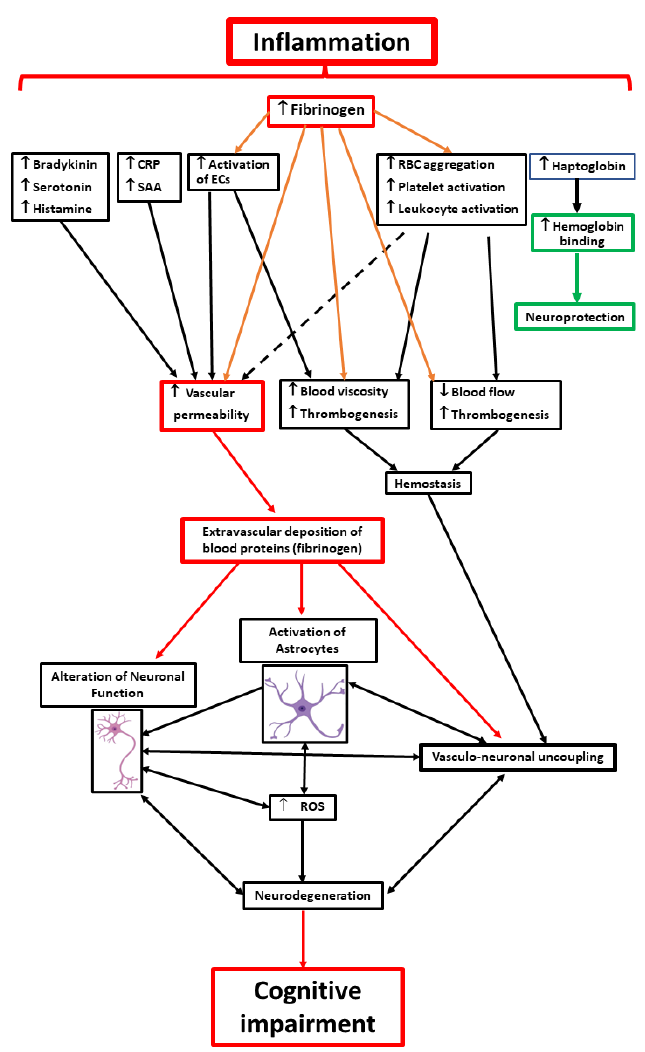
Figure 1. Schematic representation of the hypothesis of inflammation-induced vascular cognitive impairment. Among other factors that can affect vasculo-neuronal uncoupling, the factor that stands out is fibrinogen (Fg). It can be involved in changes of vascular permeability in various ways. Changes in vascular permeability result in direct activation of astrocytes and neurons through increased deposition of blood proteins (particularly of Fg) in the extravascular space, leading to neurodegeneration and a reduction in memory. Orange arrows indicate direct effects of Fg. Red arrows indicate direct effects. Dotted arrow indicates indirect effect. Green boxes and the arrow define anti-inflammatory pathway, while red boxes emphasize effects with strongest effects in VCID. Abbreviations: RBC- red blood cells, ECs – endothelial cells, CRP - C reactive protein, SAA- serum amyloid A, ROS - reactive oxygen species.